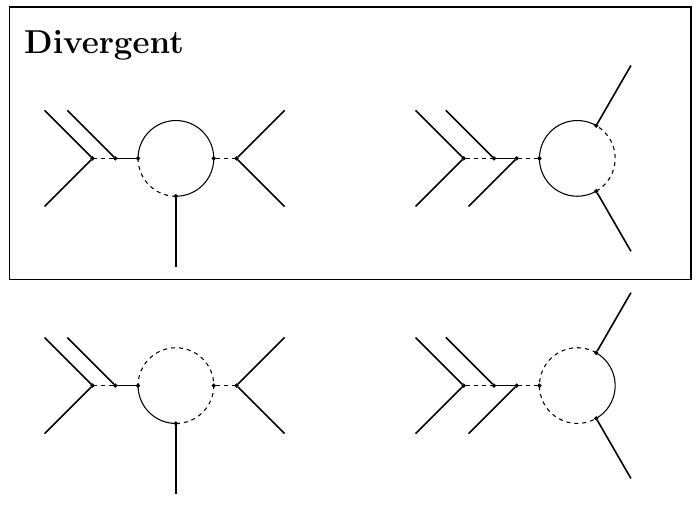
Figure 17 . Non-genuine one-loop diagrams which correspond to the one-loop generation of one of the couplings in the tree-level diagram N-0-2-1 (see figure 2). The diagrams in the box are